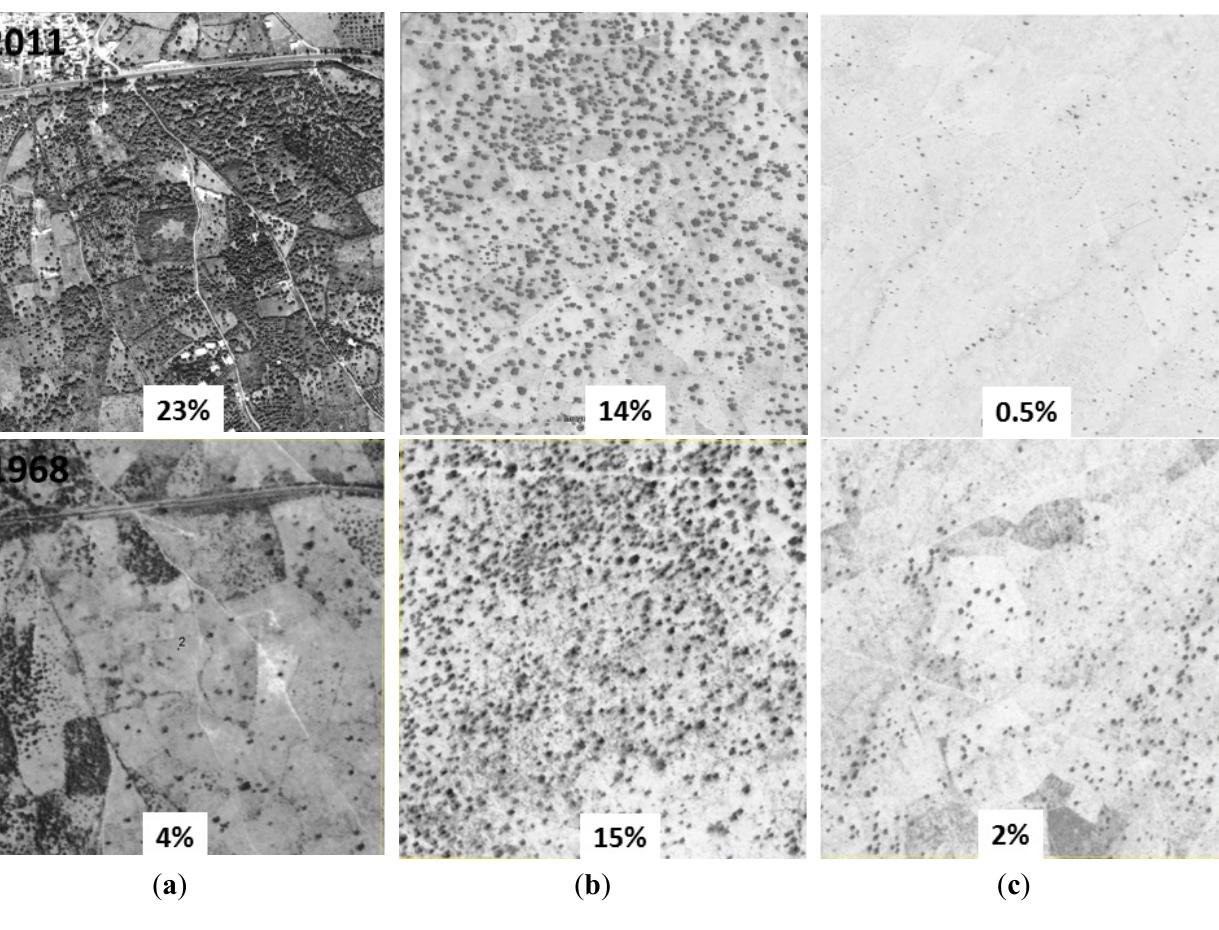
Figure 9. Examples of increasing, stable and decreasing tree cover, contrasting current very high resolution satellite imagery (top row) and Corona images from 1968 (bottom row) for selected 1 km 2 samples: ( a ) 14.76°N, 17.05°W, south of Pout in the region of Thies: arboriculture in formerly sparsely covered land, ( b ) 14.76°N, 16.66°W, east of Khombole in the region of Diourbel: relatively stable high tree density agricultural parkland (some of the smaller trees/shrubs have disappeared), ( c ) 14.78°N 16.1°W, west of Touba in the region of Diourbel: firewood needs of the city of Touba have led to a decline in tree